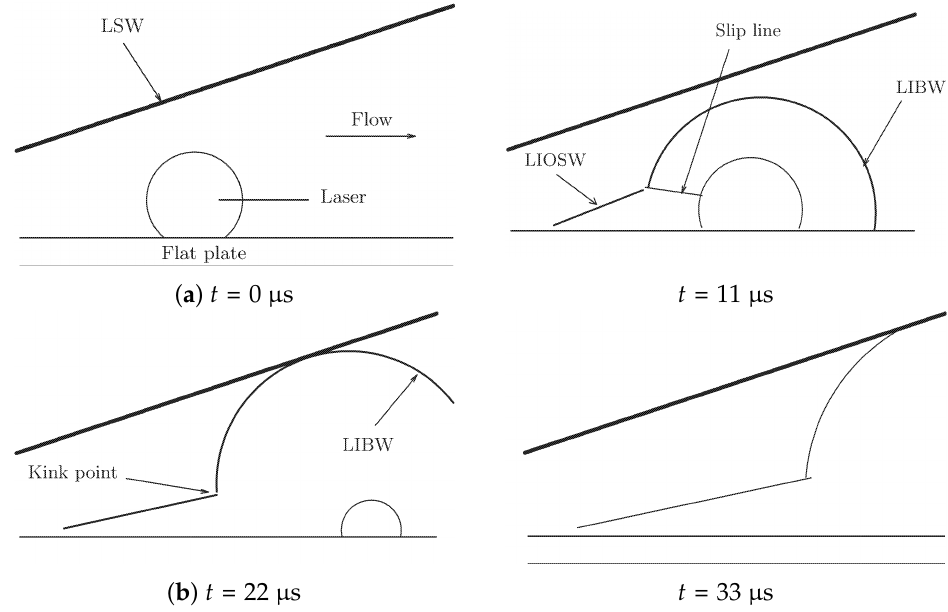
Figure 52. Schematic of schlieren images of laser